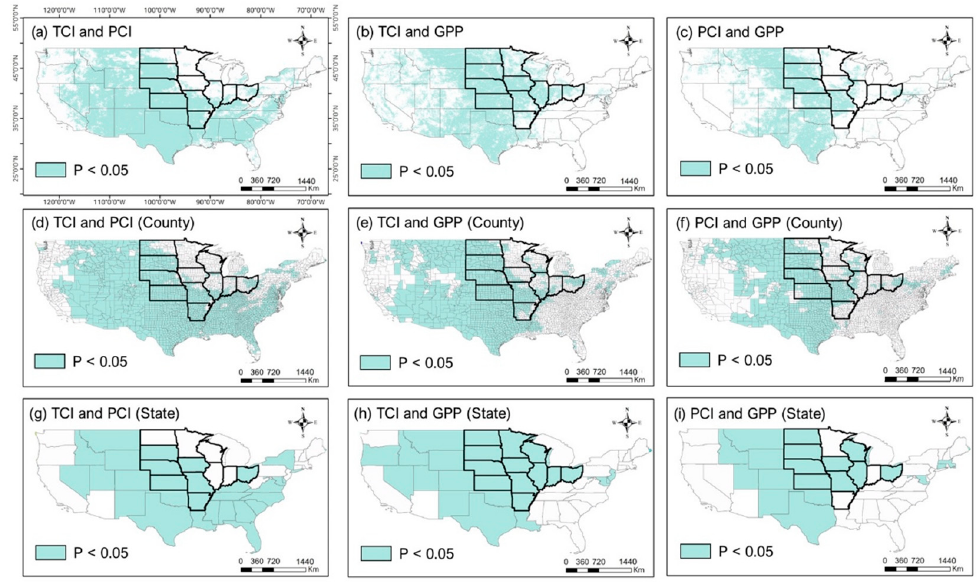
Figure A1 . Significance maps ( p -value under 0.05) for the correlation of annual variation between TCI and PCI, TCI and GPP, and PCI and GPP for pixel-level ( a – c ), county-level ( d – f ), and state-level ( g – i ) data for the average of July and August.